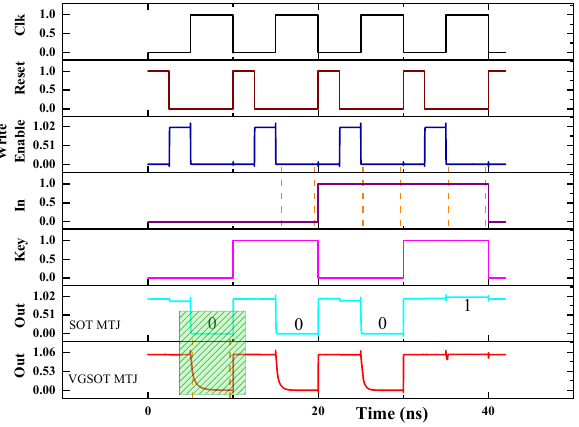
Figure 3. VGSOT and SOT logical AND operation block